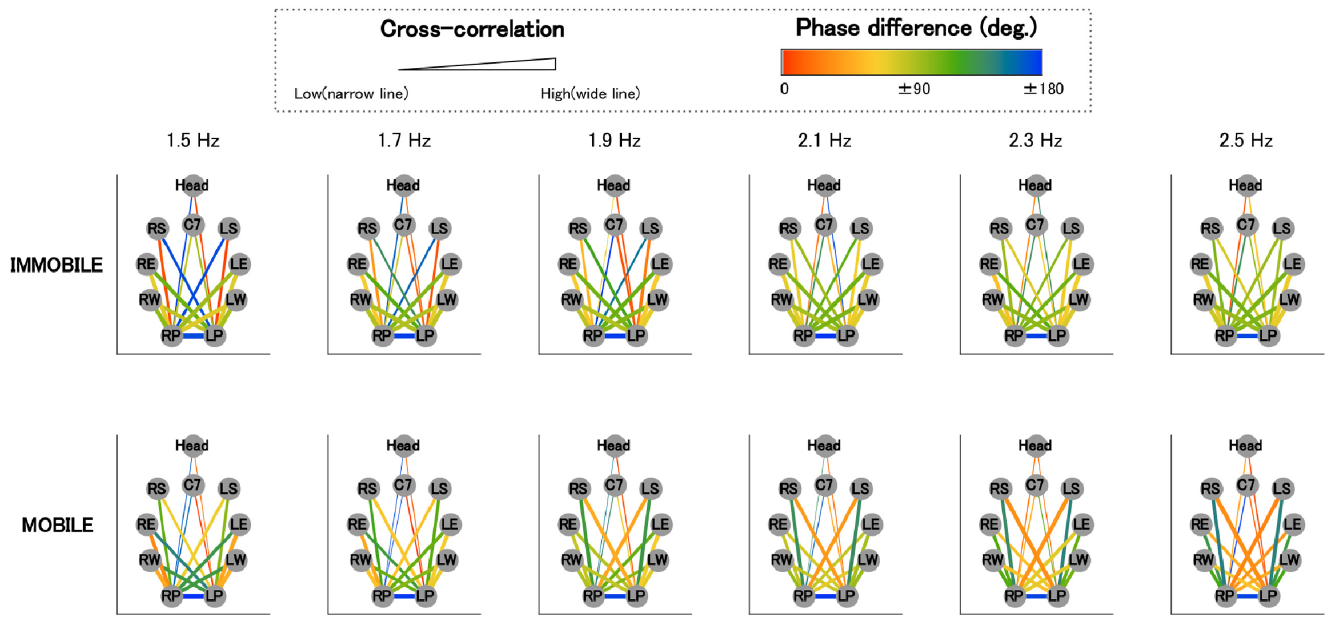
Fig 3. Visualization of the global coordinative structure (anti-phase) ( N =18). Fig 3 represent the same information as Fig 2, except that the data are for